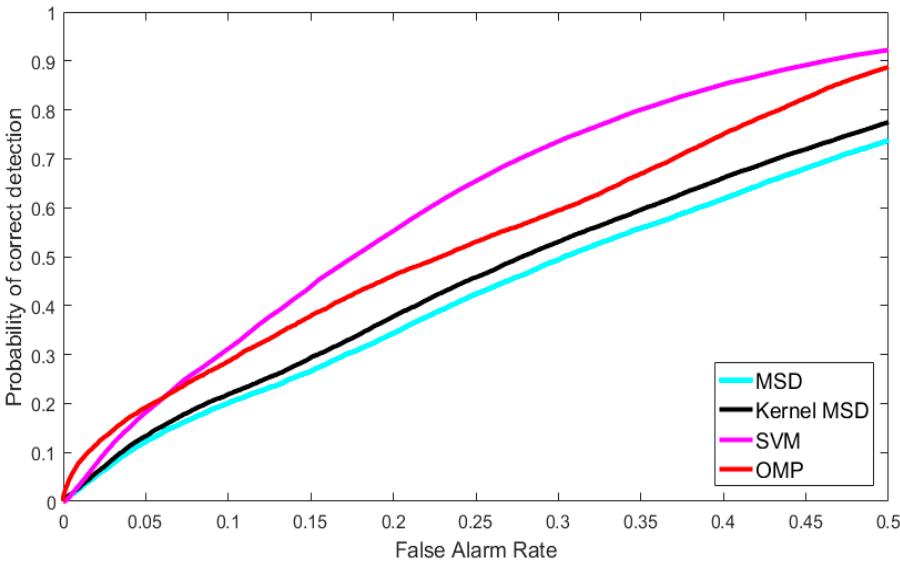
Figure 15. Performance of using color images for soil detection.